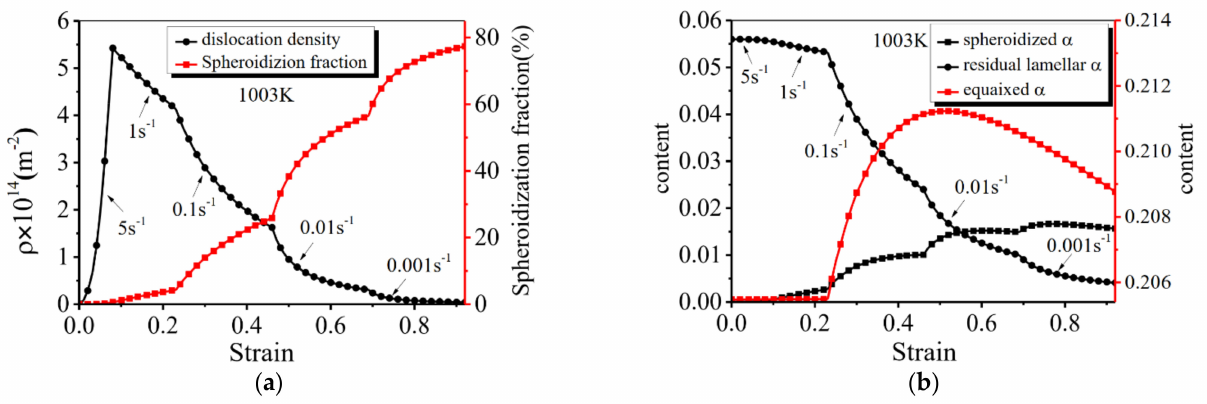
Figure 12. Prediction of microstructure evolution at 5 s − 1 –1 s − 1 –0.1 s − 1 –0.01 s − 1 –0.001 s − 1 : ( a ) dislocation density and spheroidization fraction; ( b ) the contents of the α E , α L and α SP